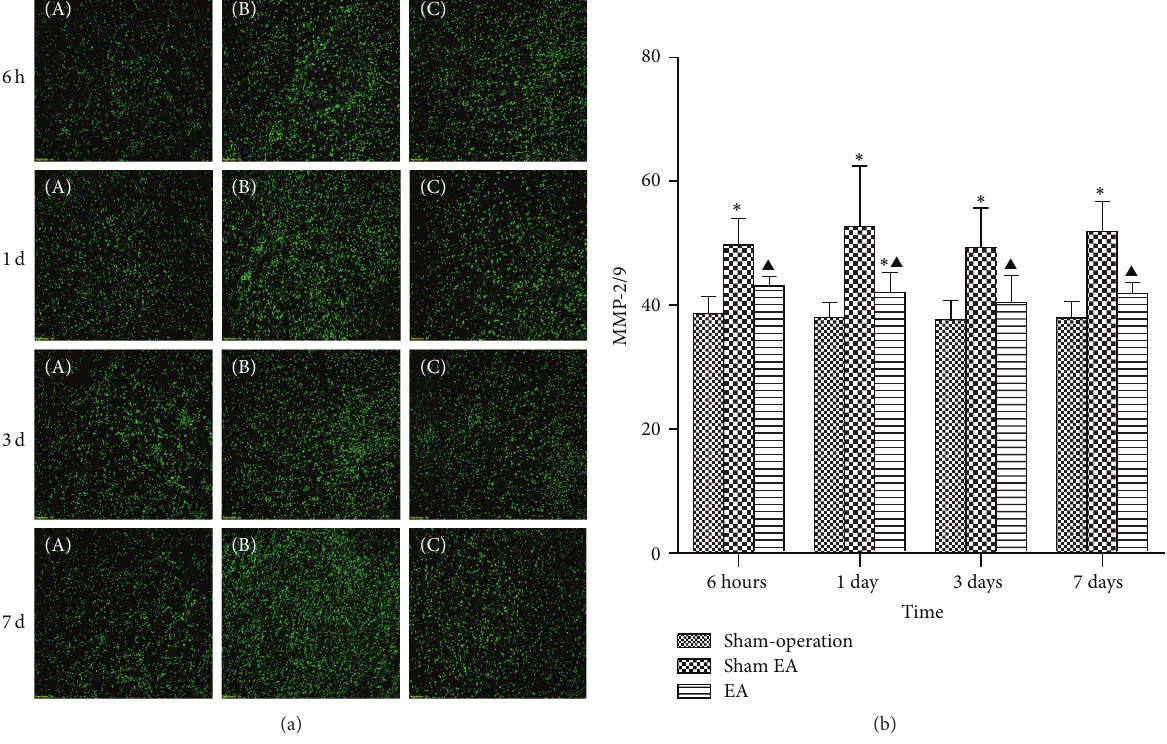
Figure 5: Representative MMPs activity in focal rat brain coronal frozen sections (mean ± SD, 𝑛 = 6 ). (a) Representative MMPs activity in focal rat brain coronal frozen sections. (A) In situ MMPs activity in Sham-operation group; (B) Sham EA group; (C) ICH plus EA group. (b) Quantitative analysis for the results of groups, respectively. One-way analysis of variance (ANOVA) was used for multiple group experiments comparisons and followed by Dunnett test for comparison of two groups within the multiple groups. ∗ 𝑃 < 0.05 , compared with Sham- operated group. 󳵳 𝑃 < 0.05 compared with Sham EA